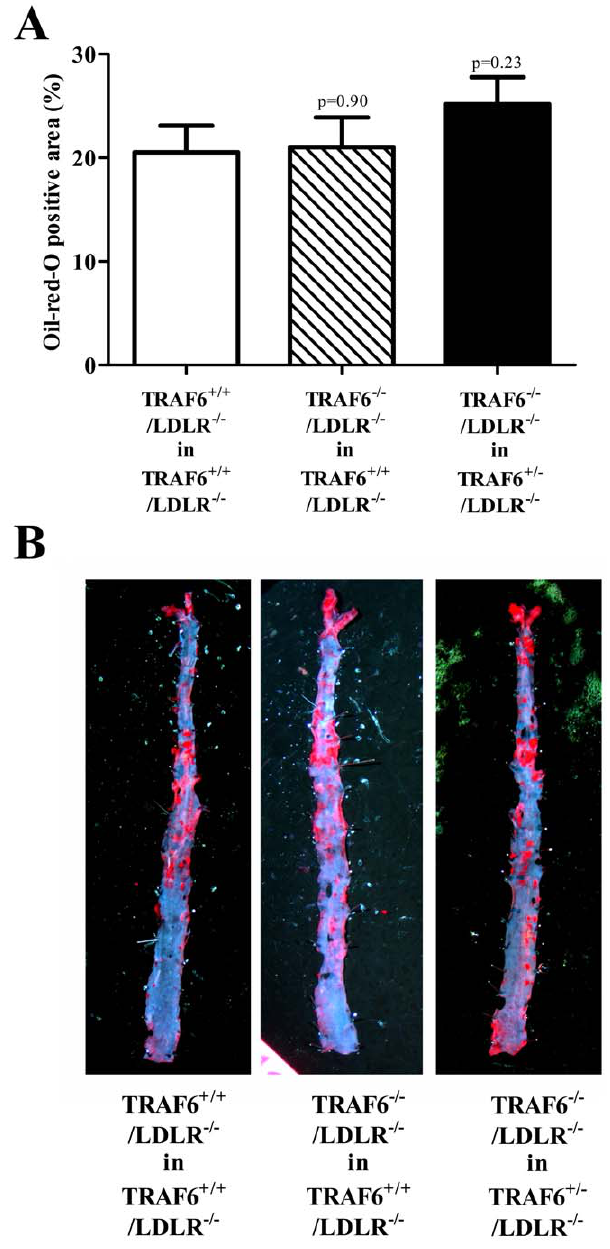
Figure 6. TRAF6 deficiency does not alter lipid deposition in the abdominal aorta. Lethally irradiated 6 week old TRAF6 + / + /LDLR 2 / 2 micereceivedTRAF6-deficient(hatchedbars,N=10)orcompetentfetalliver cells (white bars, N=10), TRAF6 + / 2 /LDLR 2 / 2 mice received TRAF6-deficient fetal liver cells (black bars, N=10) only. Subsequently, all groups consumed high cholesterol diet (HCD) for 18 weeks. Abdominal aortas were fixed in formalin,pinned,andstainedwithoilredOtodetectlipiddeposition.Oilred O-positive staining in per cent of total area is shown as mean 6 SEM in the upper panel (A), representative images are shown below (B).